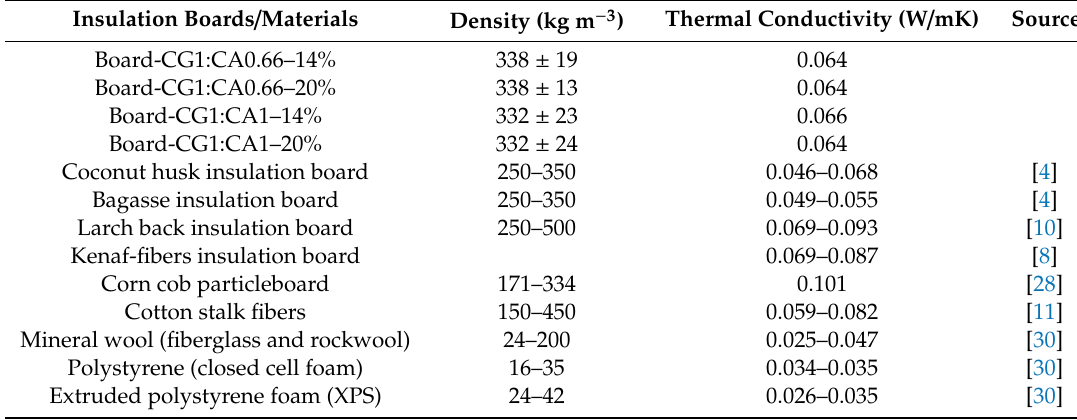
Table 5. Thermal conductivity values of insulation boards manufactured with bio-based adhesive in comparison to other insulation materials.